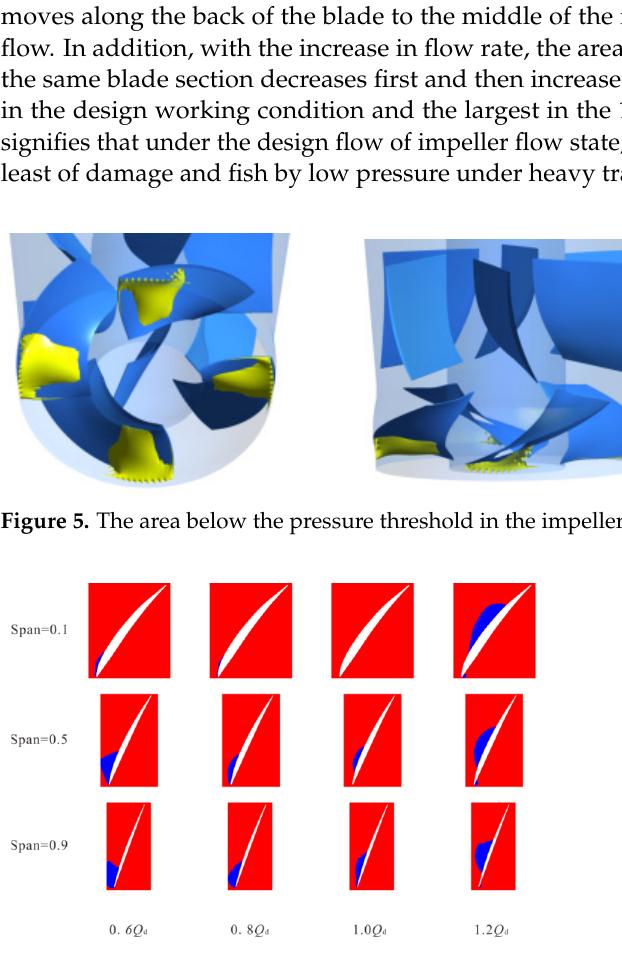
Figure 5. The area below the pressure threshold in the impeller.